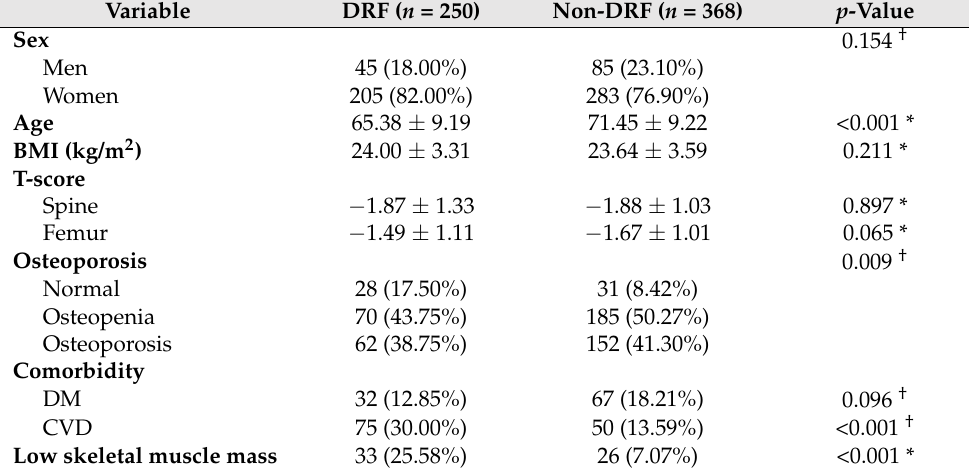
Table 1. Univariate analysis of factors associated with DRF. Variable